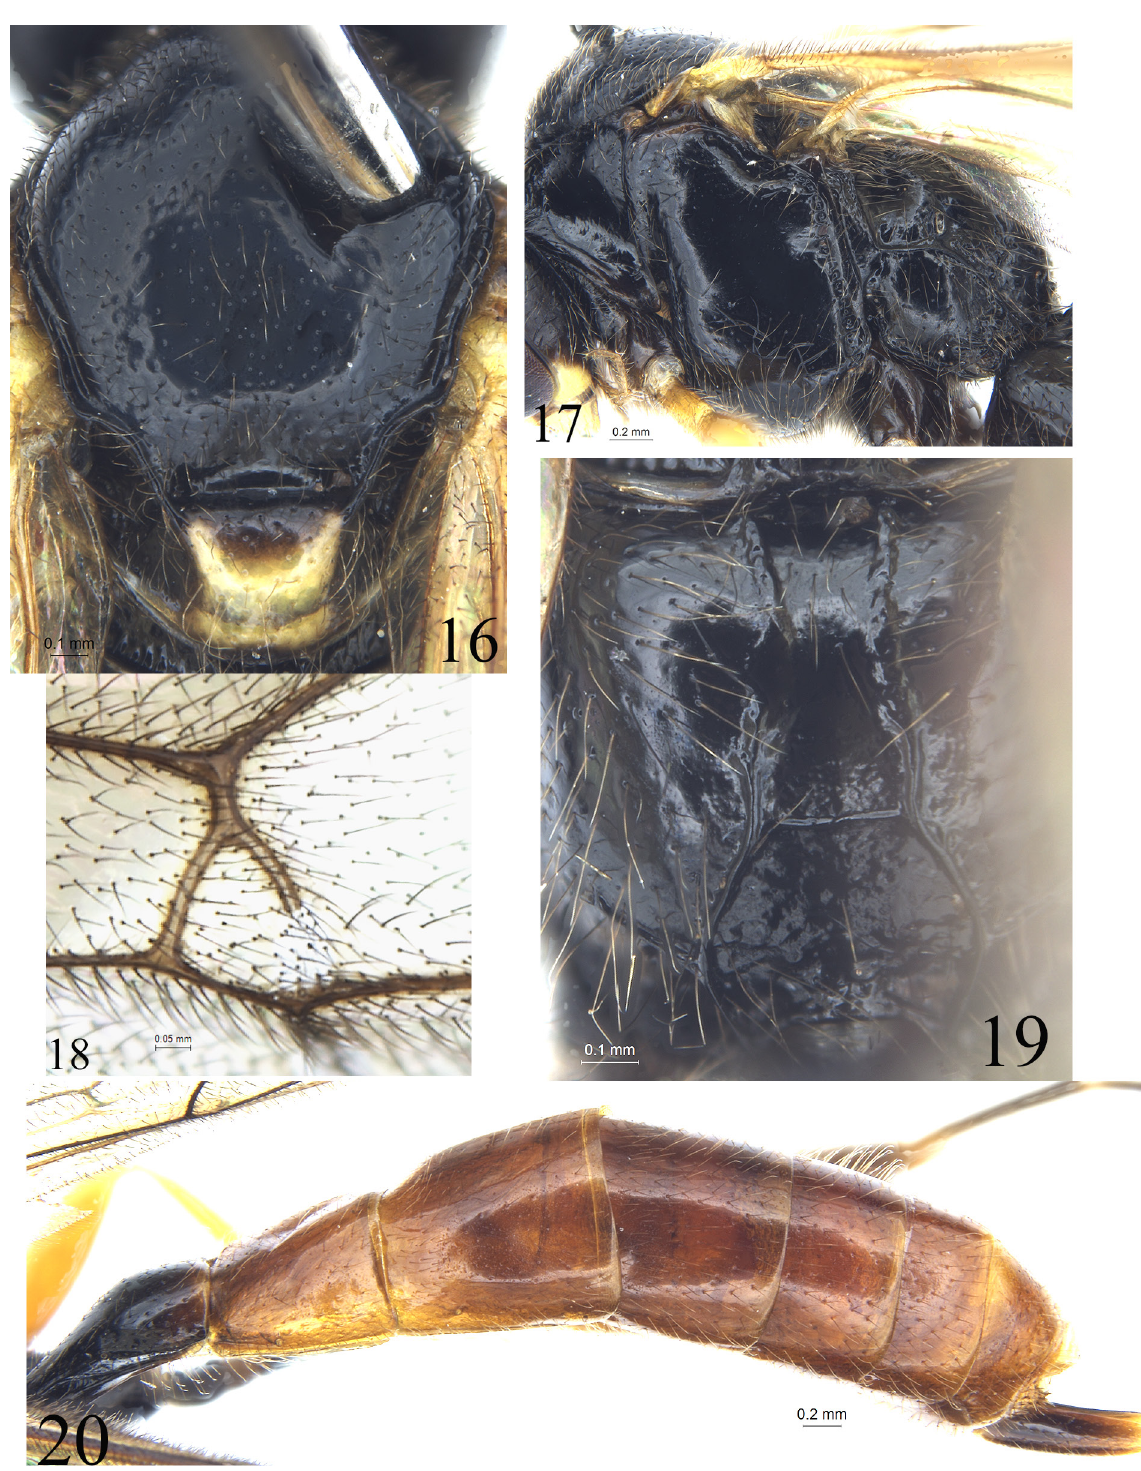
Figs 16–20. Ctenopelma lii Sheng, Sun & Li sp. nov., holotype, ♀ (GSFGPM). 16 . Mesoscutum and scutellum. 17 . Mesosoma, lateral view. 18 . Areolet. 19 . Propodeum. 20 . Metasoma, lateral